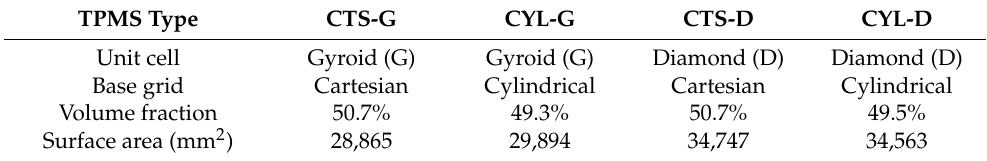
Table 2. Comparison of TPMS structures with different combinations of unit cells and base coordinates.